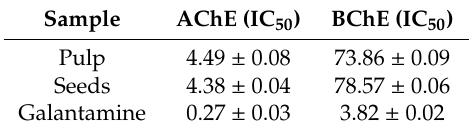
Table 3. Cholinesterase inhibitory activity of pulp and seed of G.